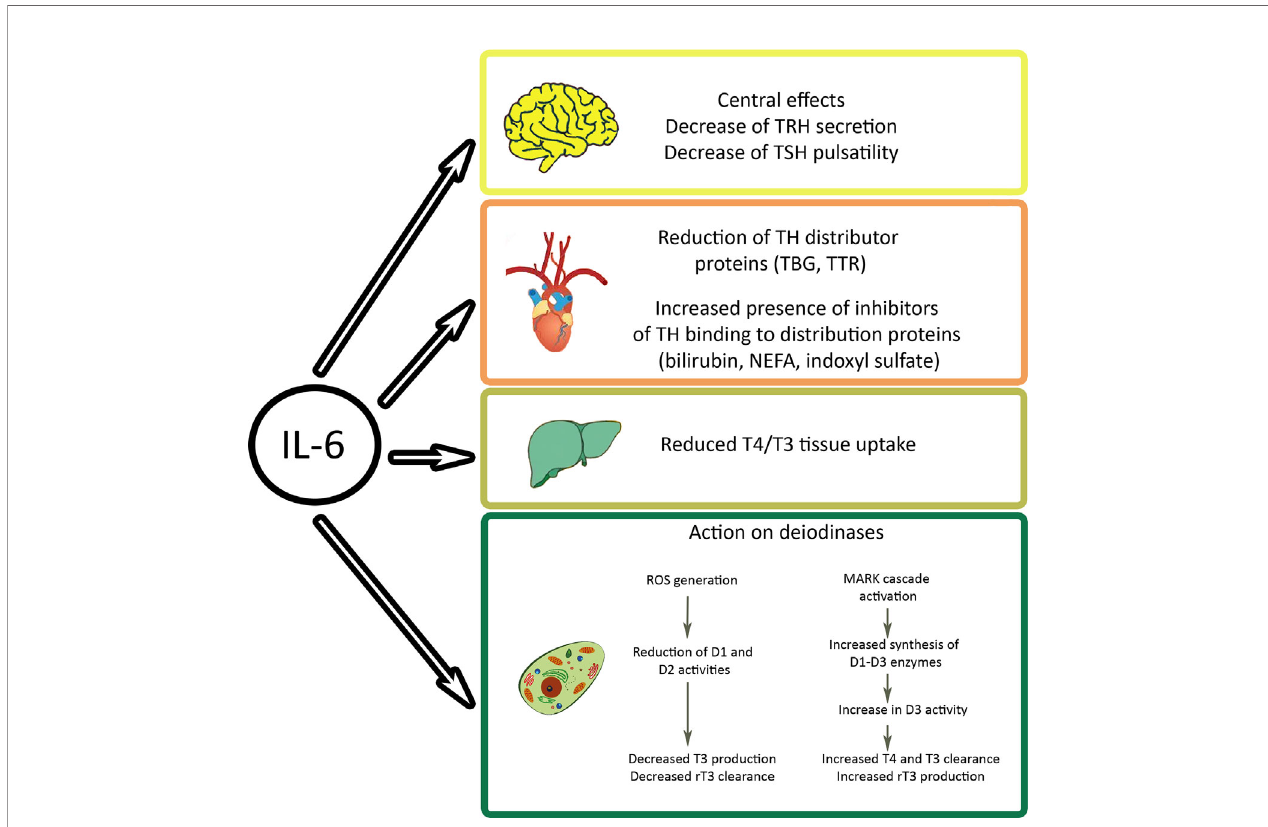
FIGURE 4 | Effects of interleukin (IL)-6 on cellular thyroid hormone levels. The in fl ammatory cytokine acts on hypothalamus and pituitary gland of the brain, on levels of free hormones, on transporters, and on cellular deiodinases. Indoxyl sulfate is a metabolite of tryptophan that accumulates in kidney damage. NEFA, non-esteri fi ed fatty acids; TBG, thyroxine binding globulin; TRH, thyrotropin releasing hormone; TSH, thyroid stimulating hormone; TTR,